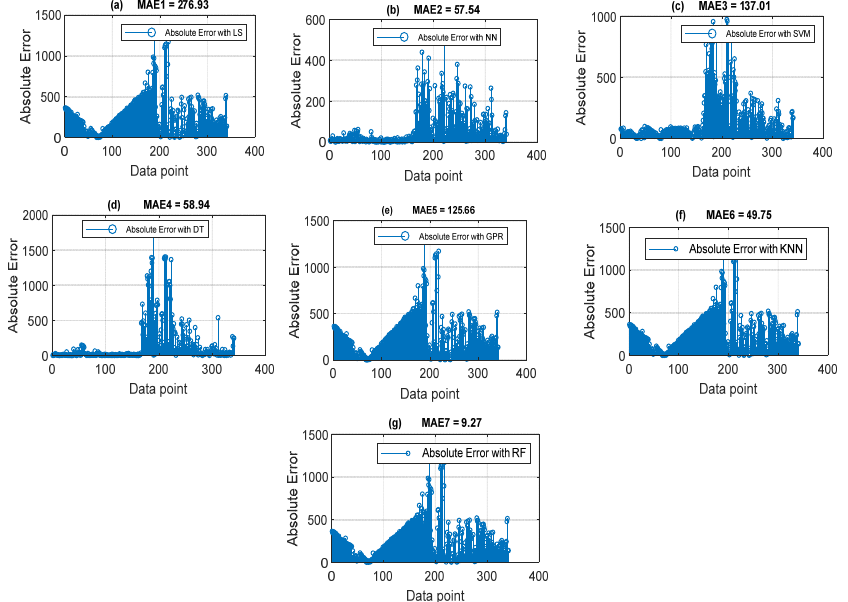
Figure 4. Throughput quality prediction accuracy with MAE attained by the different machine learning models. ( a ) Least-squares (LS). ( b ) Neural networks (NNs). ( c ) Support vector machine (SVM). ( d ) Decision tree (DT). ( e ) Gaussian process regression (GPR). ( f ) K-nearest neighbor (KNN). ( g ) Random forest (RF).